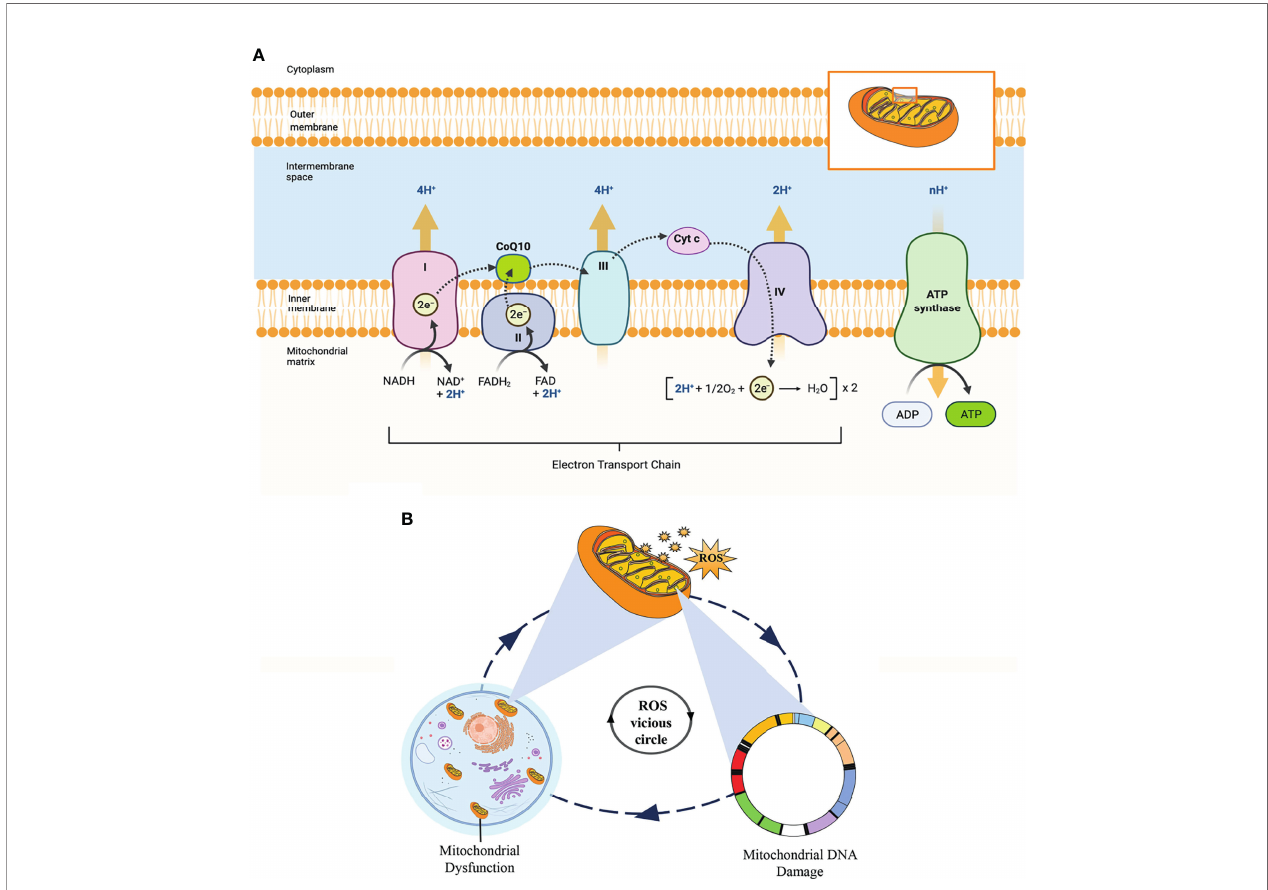
FIGURE 9 | (A) The process of oxidative phosphorylation in the mitochondria. This fi gure shows the central role of CoQ10 as an electron and proton transporter in the mitochondrial respiratory chain. (B) This “ ROS vicious cycle ” depicts the production of mitochondrial ROS causing oxidative damage that leads to mitochondrial DNA damage, mitochondrial dysfunction, and further increasing the production of